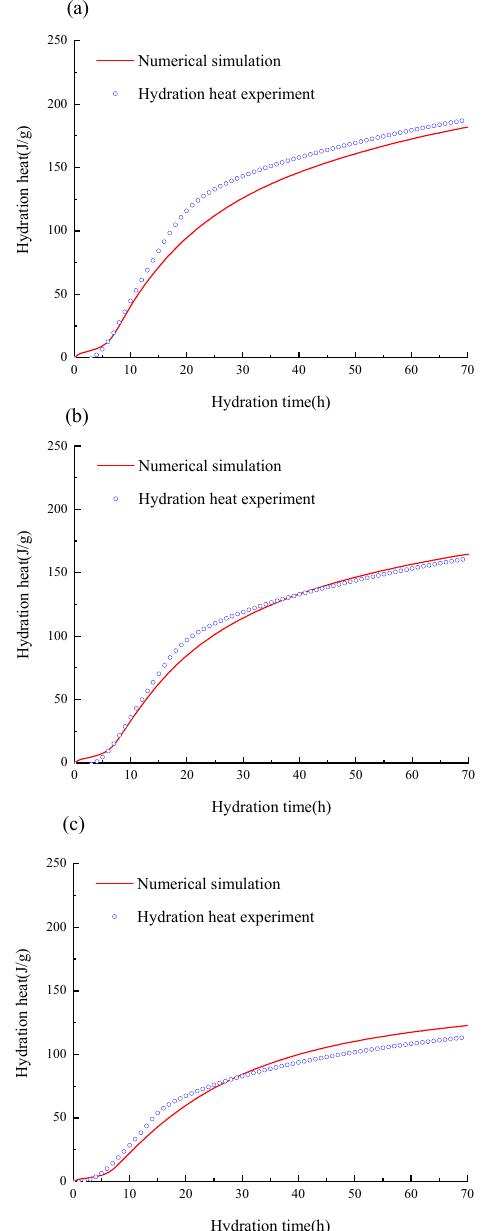
Figure 2. Comparison of experimental and numerical values of hydration heat under different amounts of glass powder. ( a ) ordinary cement ( b ) 20% glass powder ( c ) 50% glass powder.